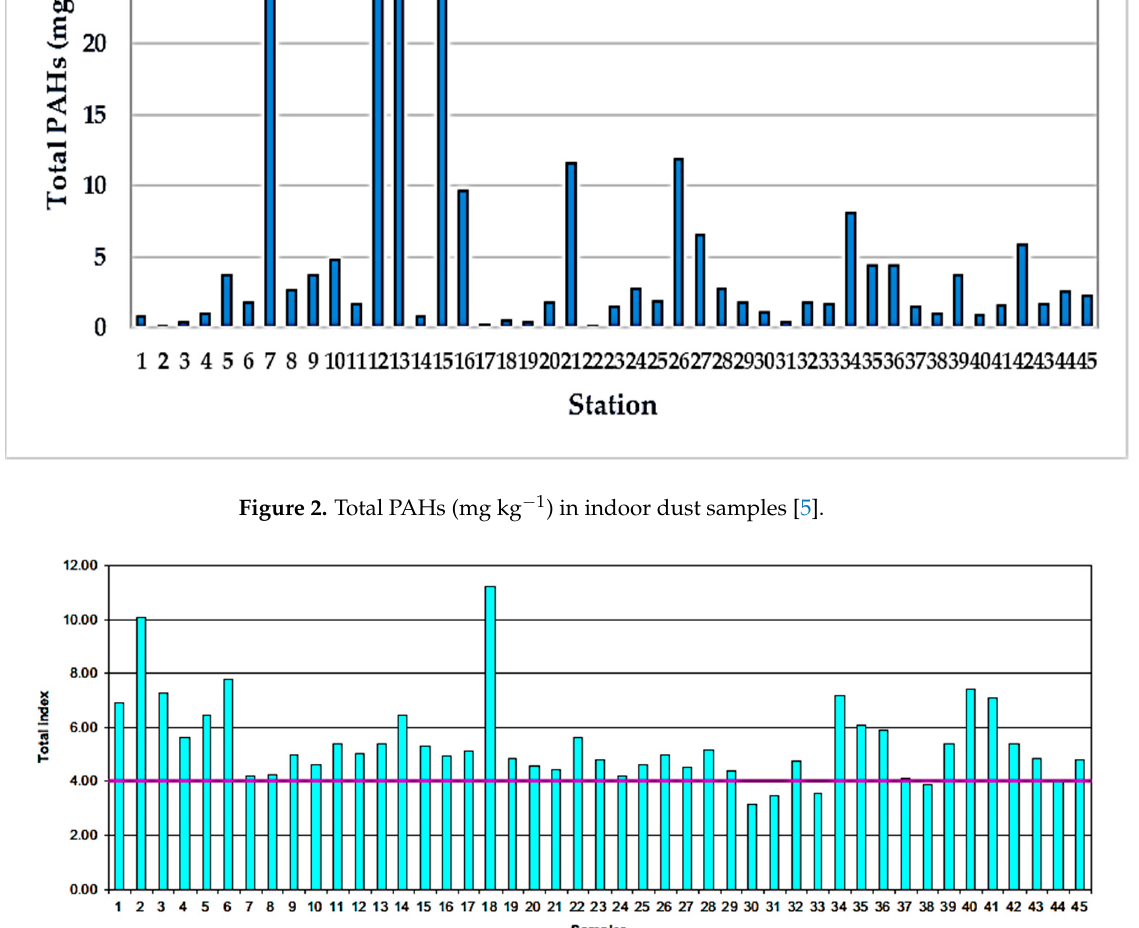
Figure 2. Total PAHs (mg kg − 1 ) in indoor dust samples [5].